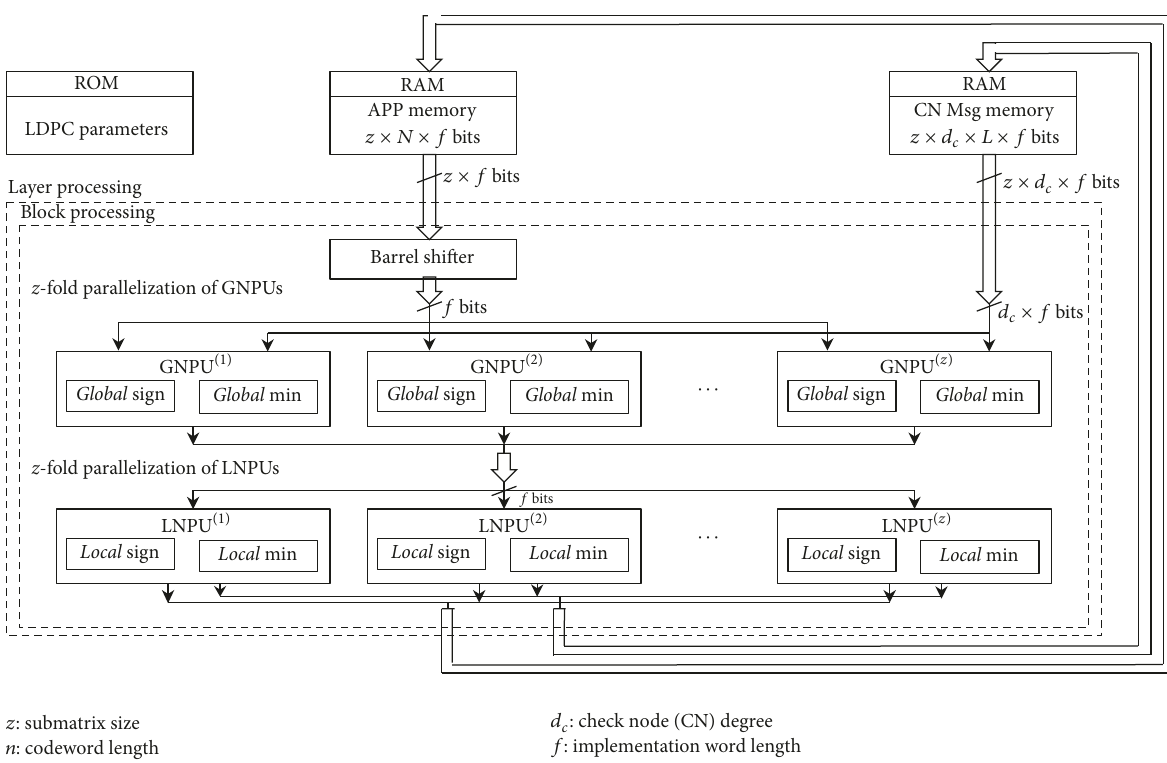
Figure 9: High-level decoder architecture showing the 𝑧 -fold parallelization of the NPUs with an emphasis on the splitting of the sign and the minimum computation given in (5). Note that, other computations in (3)–(6) are not shown for simplicity here. For both the pipelined and the nonpipelined versions, processing schedule for the inner block processing loop is as per Figure 6 and that for the outer layer processing loop is as per Figure